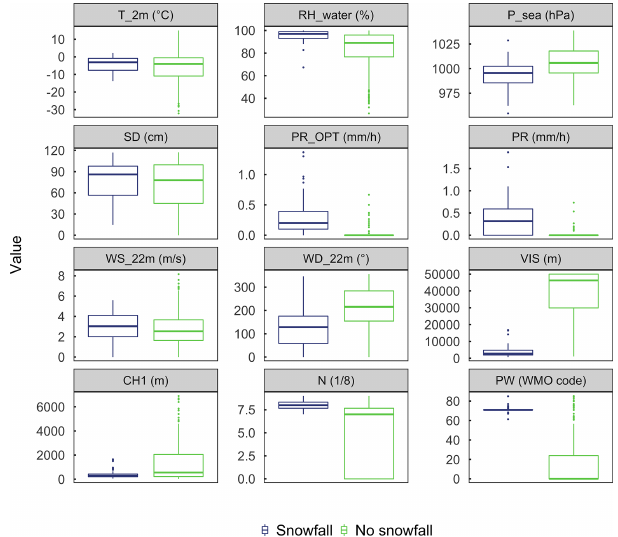
Figure 4. Boxplots (i.e. median: thick line, interquartile range: box, minima and maxima: whiskers, outliers: dots) of weather parame- ters measured at the site coinciding with radiosonde profiles dur- ing events considered as snowfall ( n = 62, blue) and as no-snowfall ( n = 406, green). The following parameters are shown from the up- per left to the bottom right: ambient air temperature at 2m above- ground ( T 2m in ◦ C), the relative humidity with respect to water (RH water in %), the pressure at sea level ( P sea in hPa), the snow depth (SD in cm), the precipitation rate measured optically (PR OPT in mmh − 1 ) and by weight (PR mmh − 1 ), the wind speed at 22m aboveground (WS 22m in ms − 1 ), the wind direction at 22m above- ground (WD 22m in ◦ ), the horizontal visibility (VIS in m), the height of the lowest cloud base (CH1 in m), the total cloudiness ( N , a number between 1 (cloud-free) and 8 (cloud-covered)), and the present weather (PW using the WMO Code 4680).